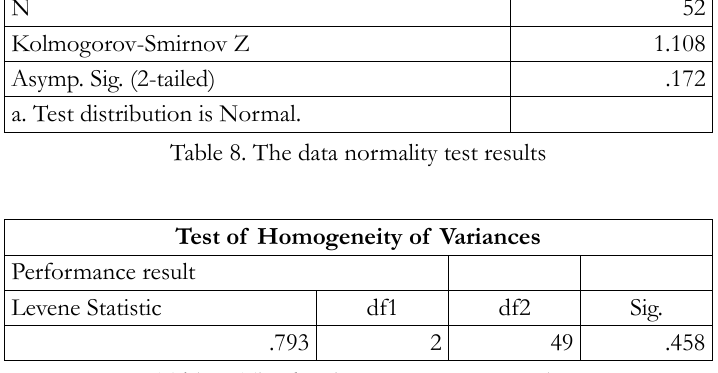
Table 9. The data homogeneity test result